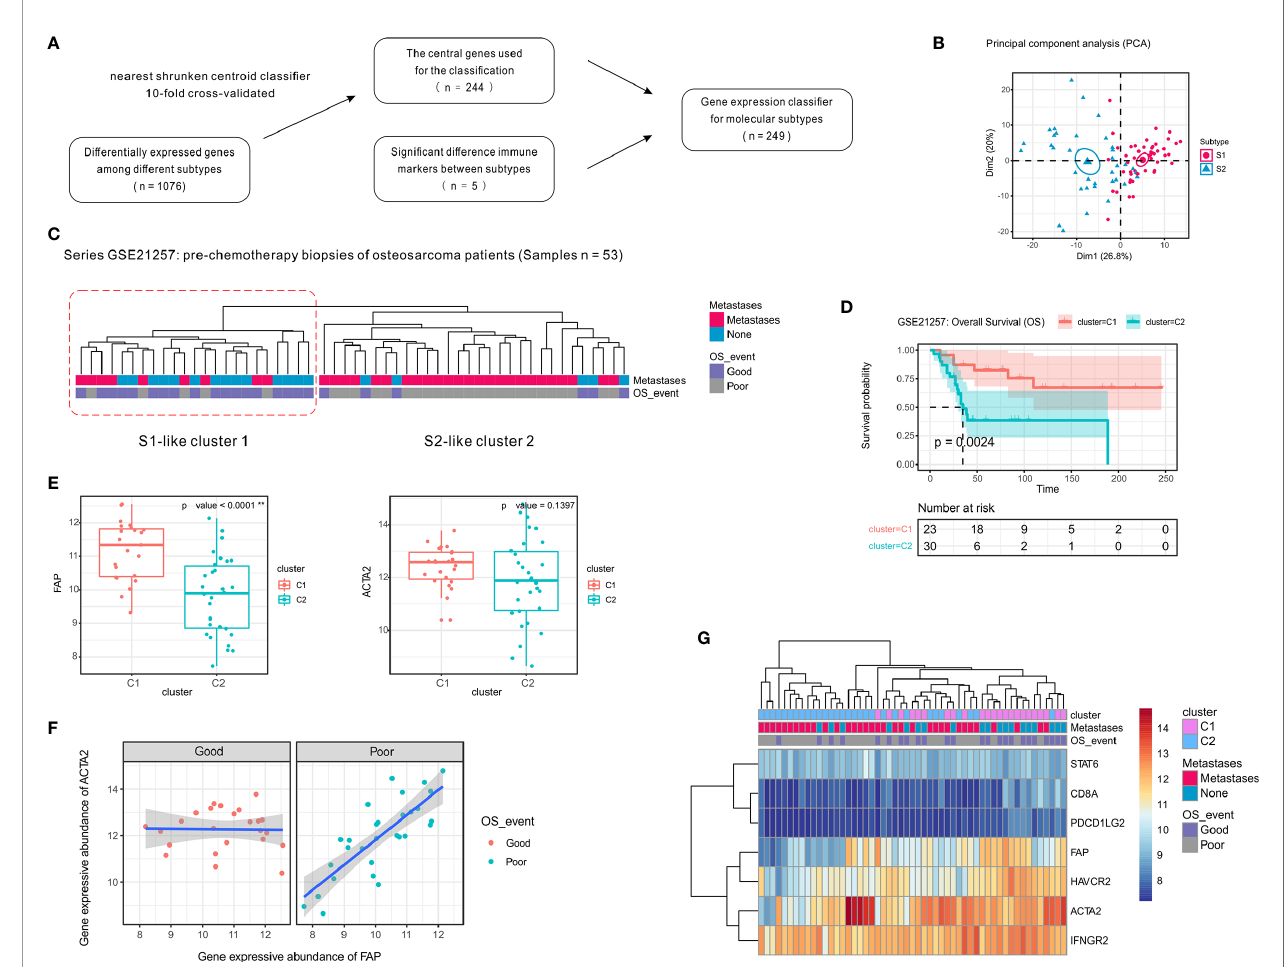
FIGURE 6 | Con fi rmation of the molecular classi fi cation of the OSA tumor microenvironment using GEO dataset GSE21257. (A) Flow diagram for signature selection and construction of the molecular classi fi er. (B) PCA for the clustering genes of the classi fi er with OSA TME subtypes S1 and S2. (C) Clustering of patients with OSA in the GSE21257 dataset using unsupervised analysis of the gene expression classi fi er. (D) Kaplan-Meier overall survival curves for patients with OSA in the GSE21257 dataset when sorted into two clusters. (E) FAP and ACTA2 expression levels in the different clusters. (F) Spearman correlation between FAP and ACTA2 expression in different prognosis groups. (G) Heatmap of FAP/ACTA2 and immune-related marker expression levels. The signi fi cance levels of the p-values are presented as **p <